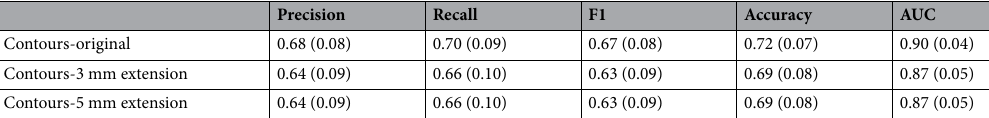
Table 1. The performance of the classifier for distinguishing non-tuberculous mycobacterial, reactive, or proliferative lymphadenopathy. Reported results indicate the mean and standard deviation (in brackets) across 100 runs.